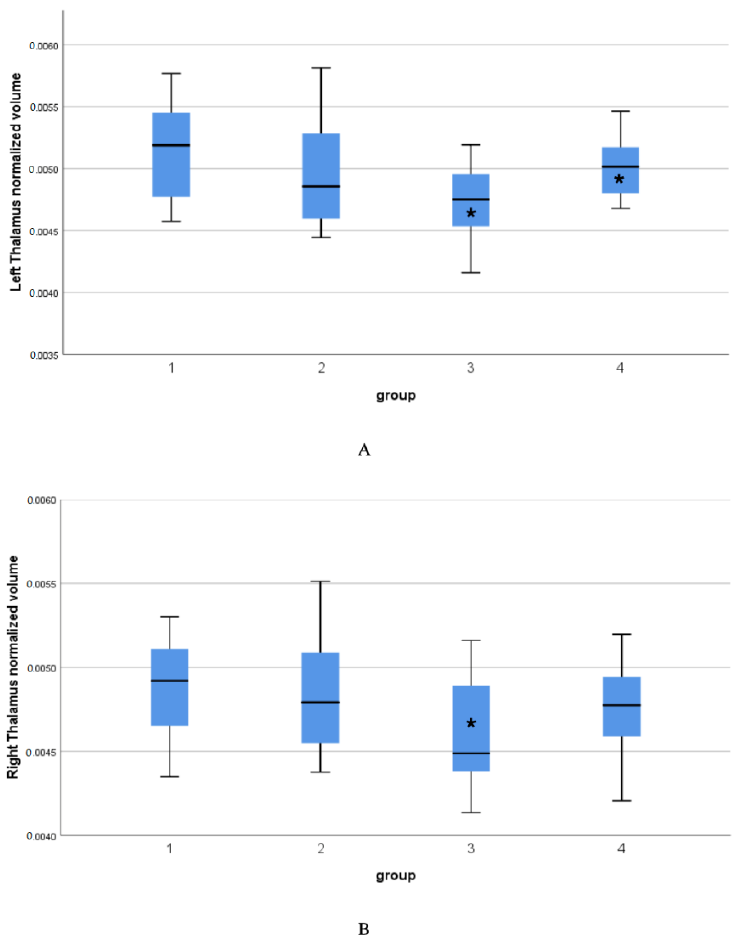
Figure 2. ( A ) the volume of the left thalamus in all groups, ( B ) the volume of the right thalamus in all group. Group: 1—control (CON), 2—functional dyspepsia (FD), 3—non-specific inflammatory bowel diseases (IBD), 4—irritable bowel syndrome (IBS). Error bars are indicating box plot. Asterisks are indicating significant differences between the IBD group and Control in the volume of the left thalamus, IBD group and IBS group in the volume of the left thalamus and IBD group vs Control group in the volume of the right thalamus. Table 2. Brain structures volume analysis and comparisons between groups. Statistically significant differences between the IBD group and Control in the volume of the left thalamus, IBD group and IBS group in the volume of the left thalamus and IBD group vs Control group in the volume of the right thalamus are highlighted. (eTIV—estimated total intracranial volume, Levene’s test—test of homogeneity of variance, ANOVA—analysis of variance, CSF—cerebrospinal fluid). Detailed data are in Supplement